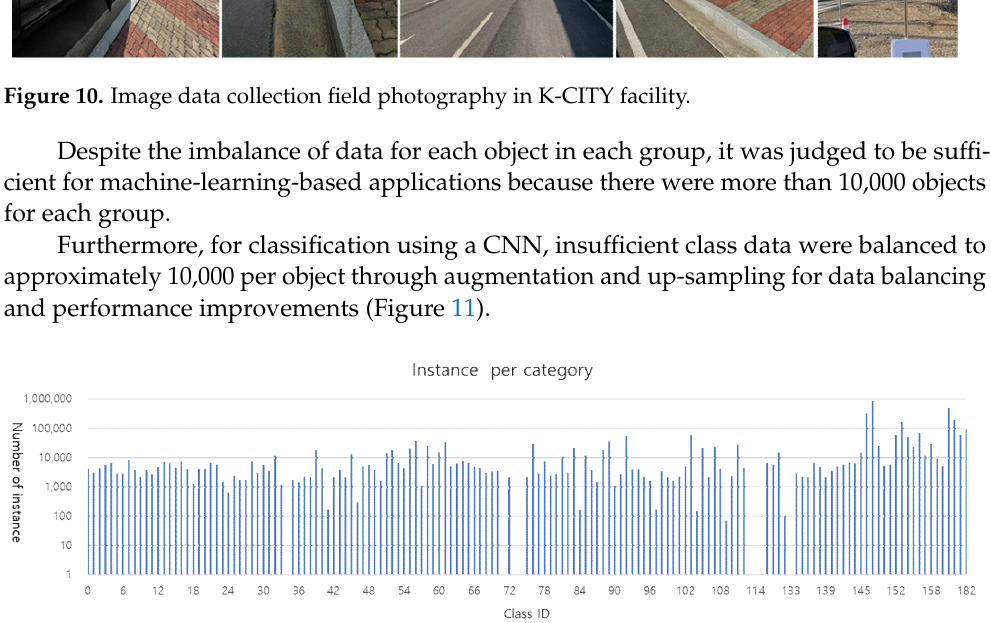
Figure 11. Number of instances in each class (151